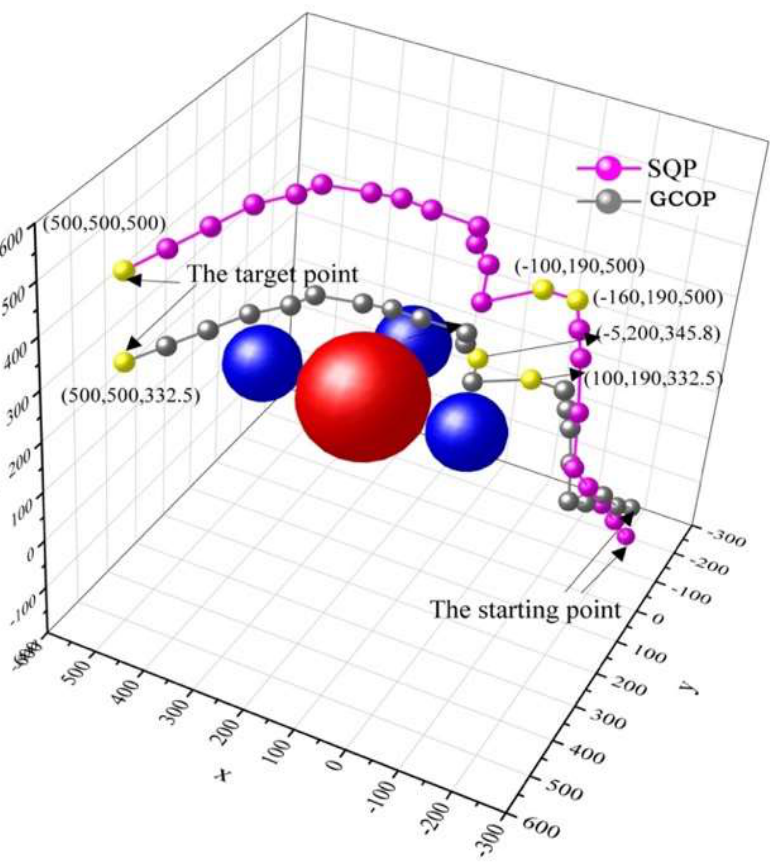
Figure 13. Robot trajectory from X -axis path perspective (the red ball represents an obstacle with a diameter = 500 mm and the blue ball represents an obstacle with a diameter = 200 mm).